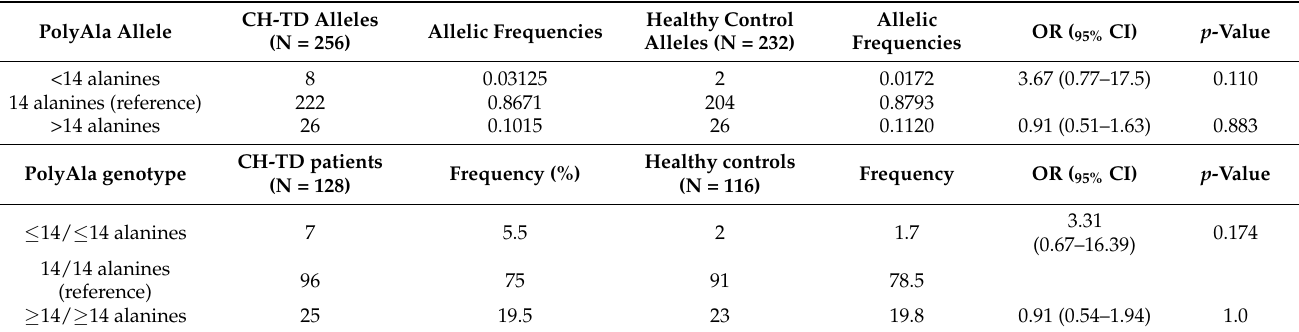
Table 2. Fisher’s exact test results for FOXE1 polyAla alleles and genotypes between CH-TD and healthy controls. PolyAla